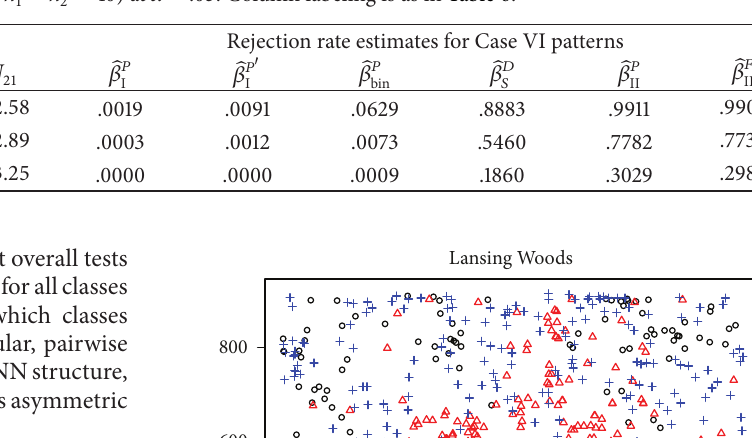
Table 13: The NNCT for the Lansing Woods data set containing black oak, maple, and white oak trees. NN species Black oak Maple White oak Base